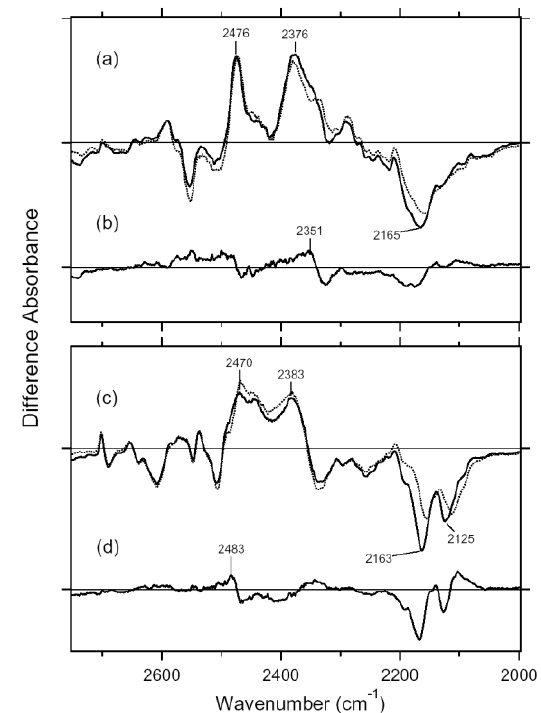
Figure 19. The 13C-ASR minus 13C-ASR (a) and the AT-ASR minus AT-ASR (c) K K spectra (pH 7) in the 2,750–2,000 cm -1 region for [  - 15 N]lysine-labeled (dotted line) and unlabeled (solid line) ASR. Double difference spectra in (a) and (c) (solid line minus dotted line) are shown in (b) and (d), respectively. The samples were hydrated with D O, and 2 spectra were measured at 77 K. One division of the y-axis corresponds to 0.0007 absorbance units. These figures are reprinted with permission from Kawanabe et al. [59]. Copyright 2006 American Chemical